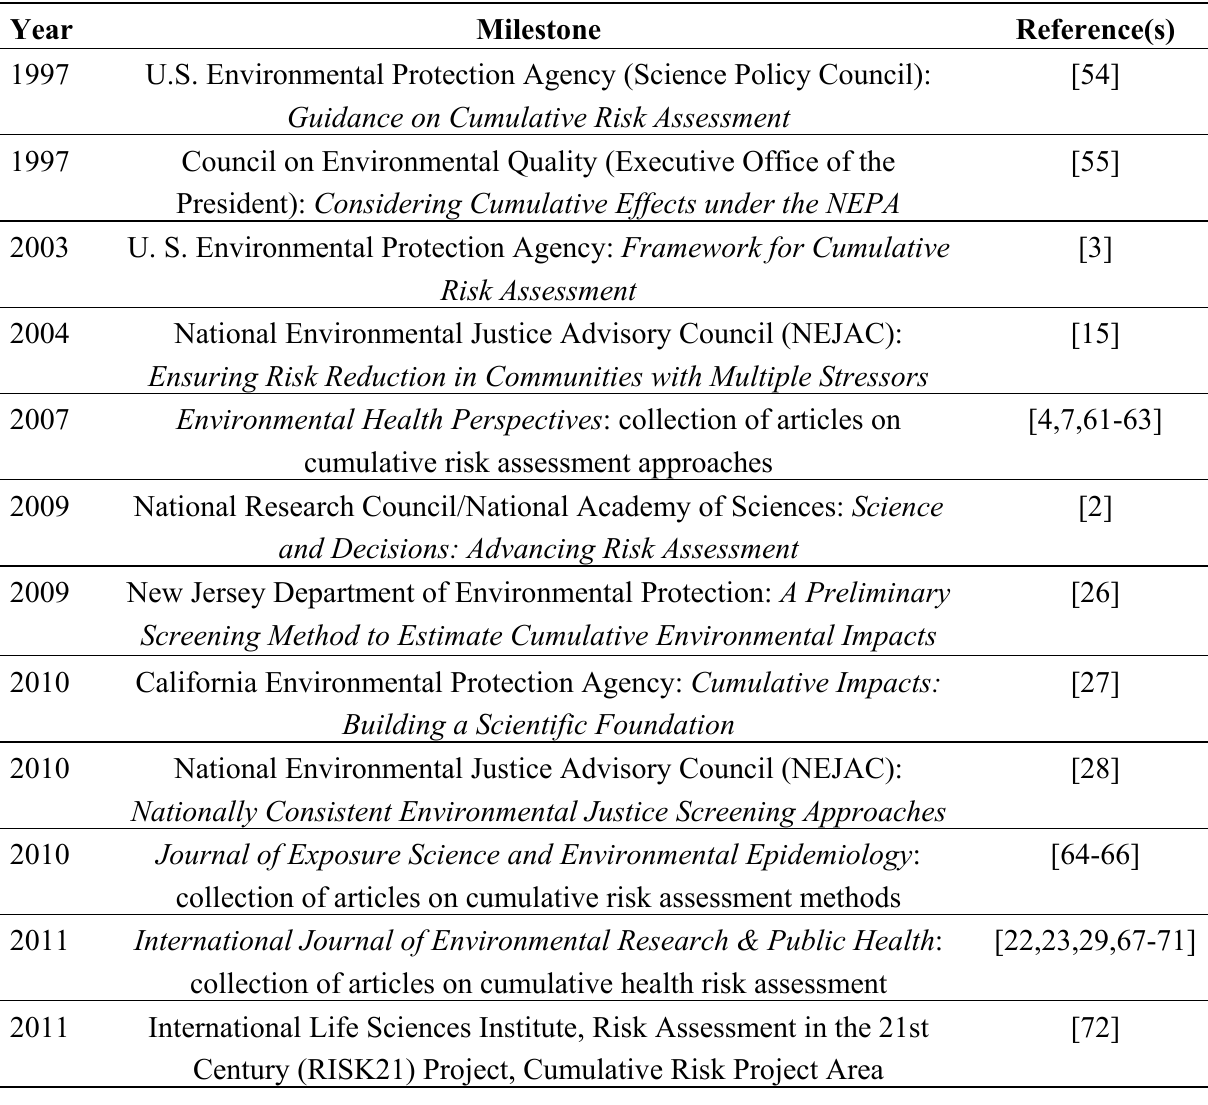
Table 2. Selected U.S. Milestones in the Evolution of Cumulative Risk Assessment for Health Effects from Exposure to a Combination of Chemical and Nonchemical